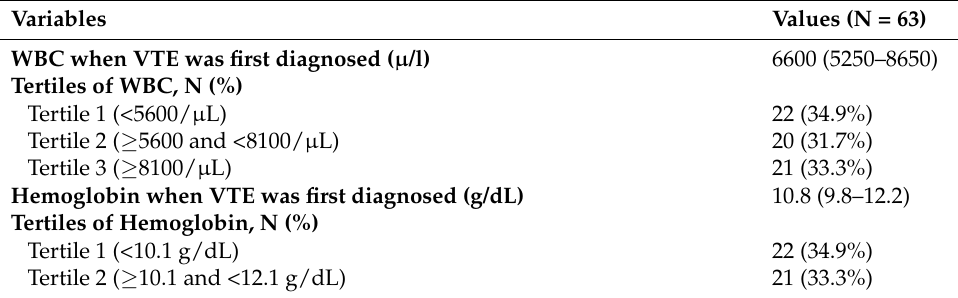
Table 2. Laboratory characteristics of the study